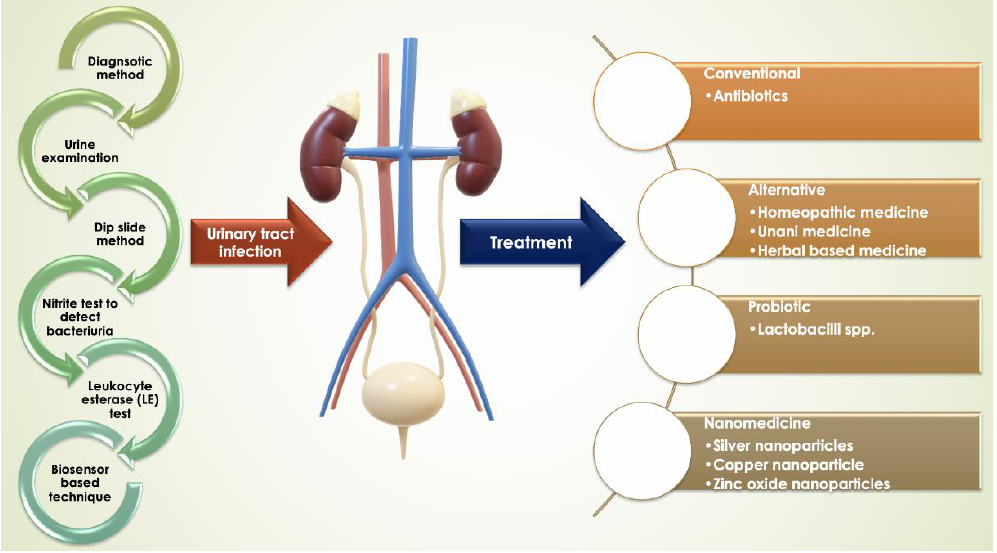
Figure 1. Representation of UTI, prevalence, diagnosis, and treatments.